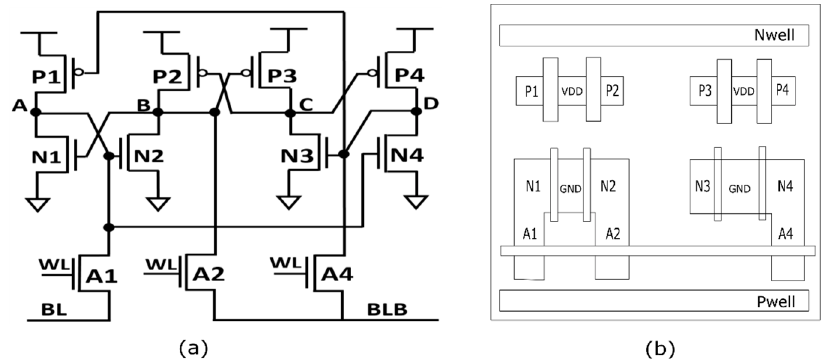
Figure 19. ( a ) Schematic of Regular_11T structure; ( b ) layout of Regular_11T structure.